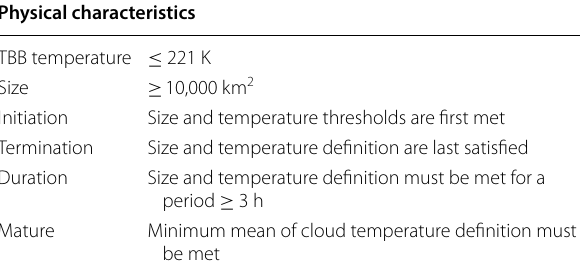
Table 2 Modified specific identification of MCS used in this